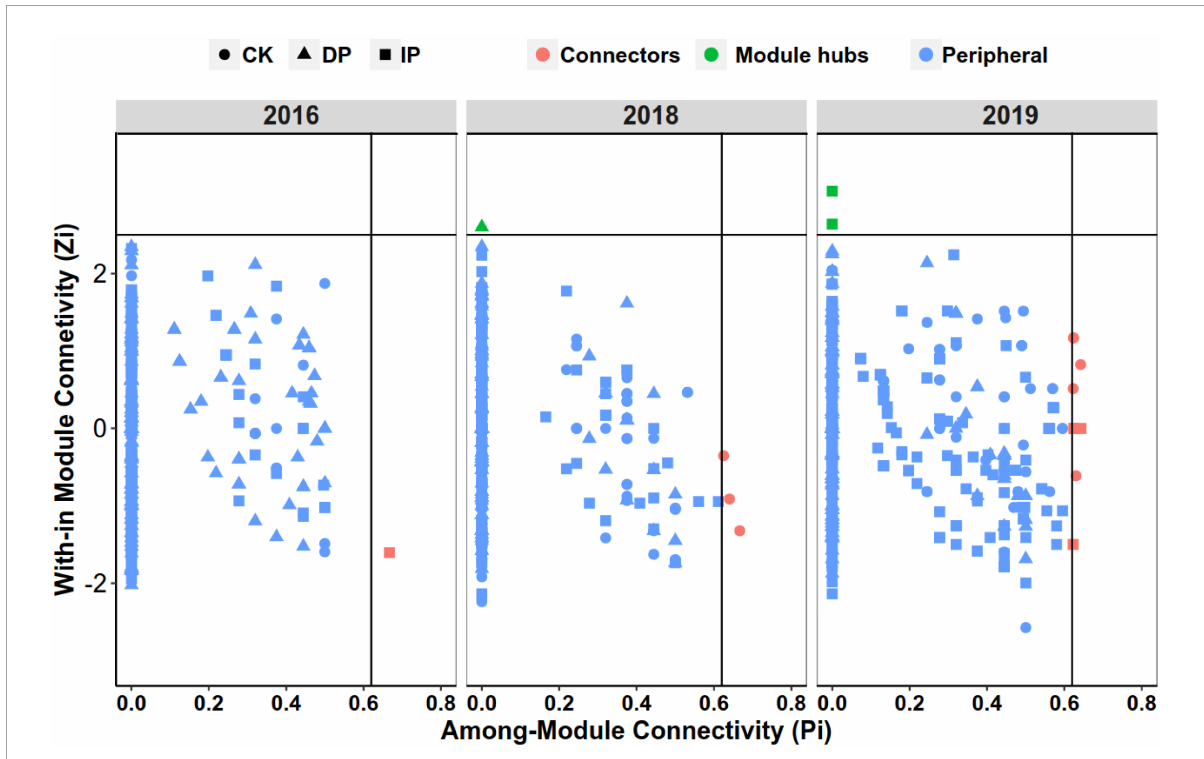
FIGURE4 Identification of keystone taxa based on their topological roles in different precipitation gradient networks in 2016, 2018, and 2019. Module hubs are identified as Zi ≥ 2.5, Pi < 0.62; connectors are identified as Zi < 2.5, Pi ≥ 0.62. CK, control; DP, decreased precipitation; IP, increased